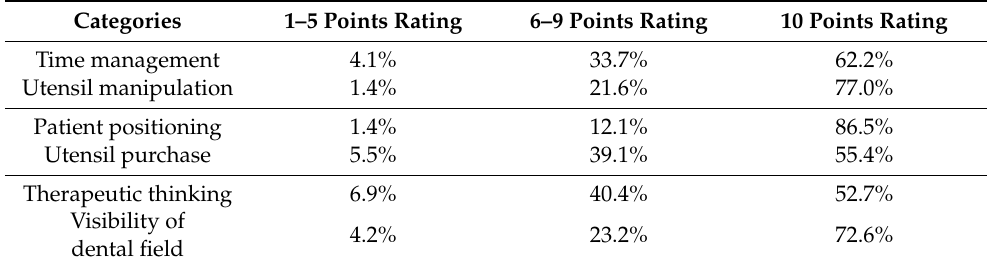
Table 1. Self-evaluation scores on improvements made to the dental clinical act due to attending ergonomics training in the second year of the dental education process.